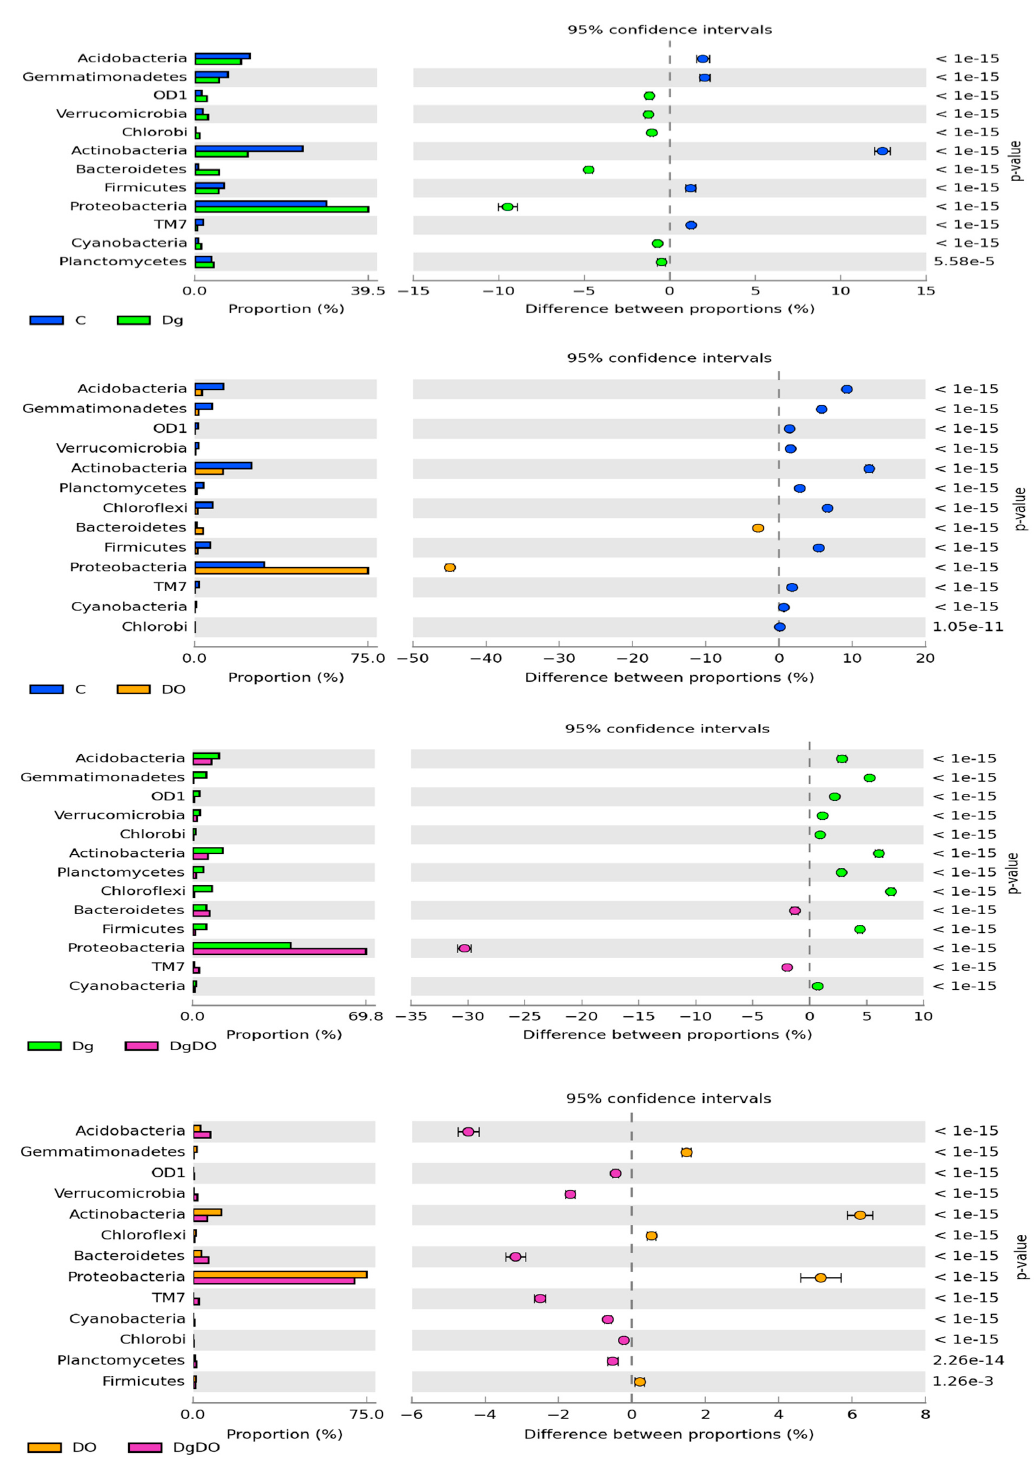
Figure 4. The relative abundance of the dominant bacterial type in the soil with a difference between proportions ≥ 1%. C—non-polluted and non-sown soil, Dg—non-polluted soil sown with Dactylis glomerata , DO—non-sown soil polluted with diesel oil, DgDO—soil polluted with diesel oil and sown with Dactylis glomerata.